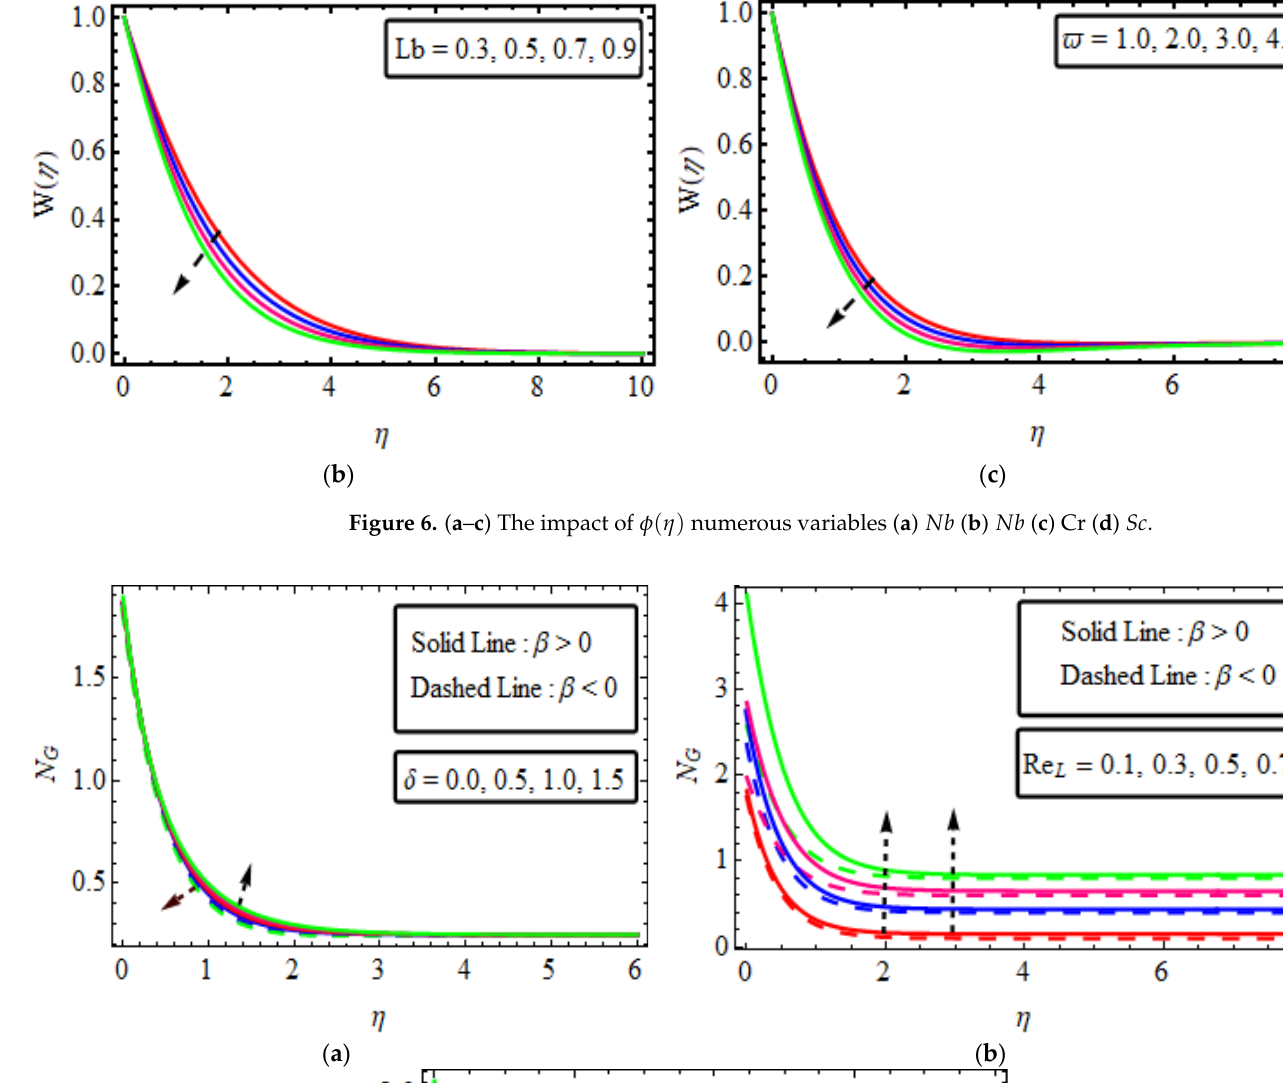
N G numerous variables ( a ) δ ( b ) Re L ( c ) Br